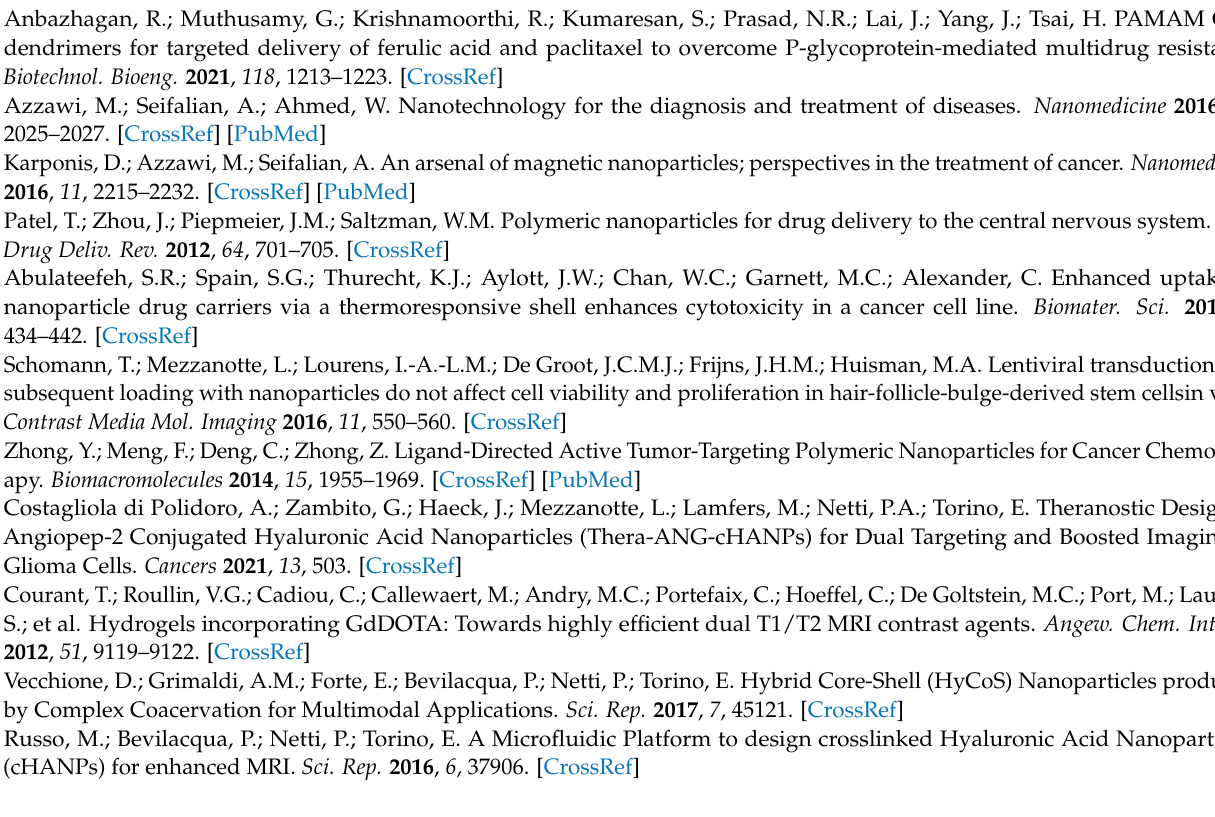
rate ratio conditions tested, Table S2: Parameters tested during the experimental campaign after the addition of Gd-DTPA, Figure S3: Representative SEM image of CS 0.2% w/v at CS:HA=6.25 and FR 2 = 0.5, Table S3: Calculation of encapsulation efficiency starting by the measurements taken from the ICP-MS, Figure S4: Representative SEM images of different CS:HA ratios at FR 2 = 0.5, Table S4: Calculation of relaxation enhancement starting by the measurements taken from the the benchtop relaxometer, Figure S5: Representative histograms and distribution curves of NPs at FR 2 = 0.5 and CS:HA ratio equal to 1.56 or 3.12 at the two operational regimes, Figure S6: NPs size as a function of FR 2 (0.05, 0.2 and 0.4) at two TPP concentration (0.012 or 0.003% w/v ) and SEM images of NPs at two TPP concentrations and two different flow rates, Figure S7: Visual plot displaying morphology of NPs at low flow rate regime as a function of FR 2 and CS:HA ratio, Figure S8: Visual plot displaying morphology of NPs at high flow rate regime as a function of FR 2 and CS:HA ratio, Figure S9: Reynolds number as a function of the chitosan concentration at high and low flow rate regime, Figure S10: Reynolds number as a function of the total flow rate at different chitosan concentrations, Figure S11: Spectrofluorometer calibration curve for Atto-488 in the range 0-200 pmol/mL, Figure S12: In vitro cytotoxicity of CS-HA NPs in contact with U87 MG cells at two different time